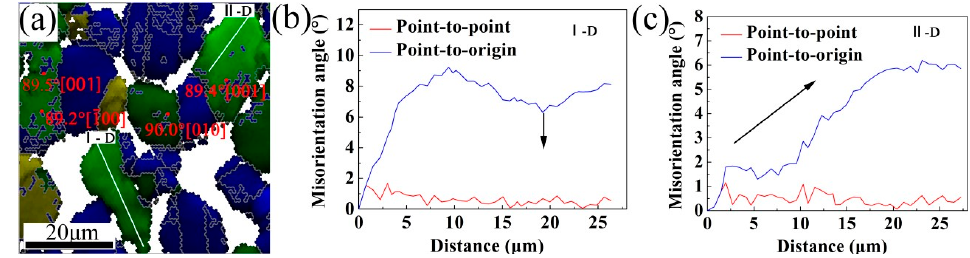
( b , c ) Misorientations measured along the lines denoted as I-D and II-D within the deformed grains (deformed grain “D”).